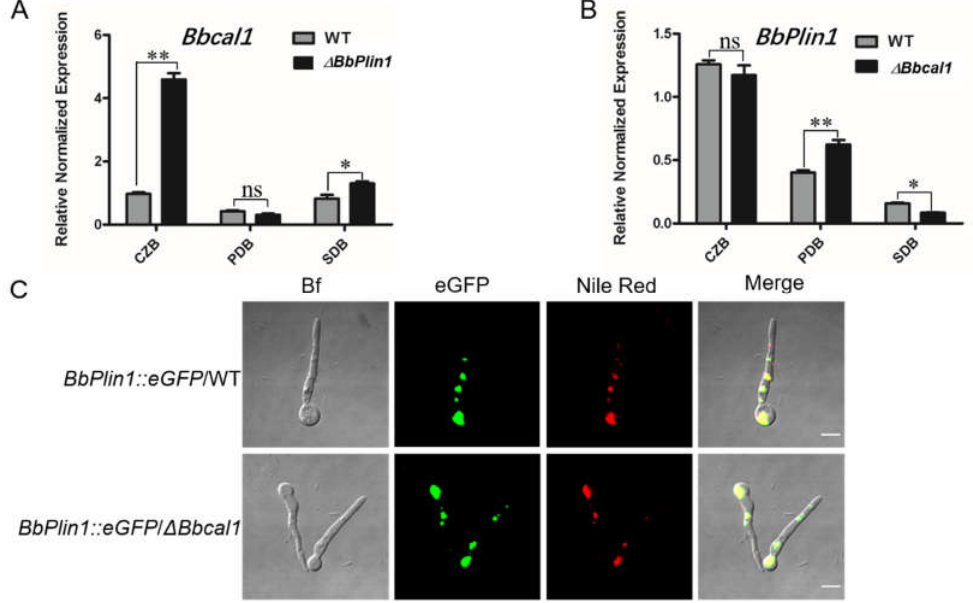
Figure 6. Effects of BbCal1 and BbPlin1 targeted gene deletion on gene expression of BbPlin1 and BbCal1 , respectively. ( A ) Gene expression analysis of BbCal1 in B. bassiana wild–type strain and Δ bbPlin1 deletion mutant. Fungal cells were inoculated into CZB, PDB, and SDB for 3 d and total RNA was extracted for use in RT–PCR experiments. ( B ) BbPlin1 expression in B. bassiana wild–type strain and Δ bbcal1 deletion mutant. ( C ) Representative images of eGFP fluorescence signals of B. bassiana Δ bbCal1 harboring the PbbPlin1::eGFP construct. Fungal conidia were harvested from indicated B. bassiana strains grown on PDA for 2 weeks at 26 °C. All experiments were performed using three technical replicates and the entire experiment was performed three times. Data are given as ± SE. Stars represent statistical difference (* p < 0.05; ** p < 0.01; ns, no significant, t test).